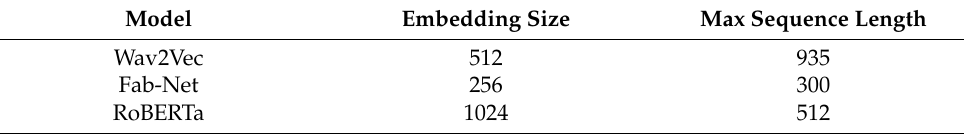
Table 1. SSL model representation and the respective embedding size and sequence